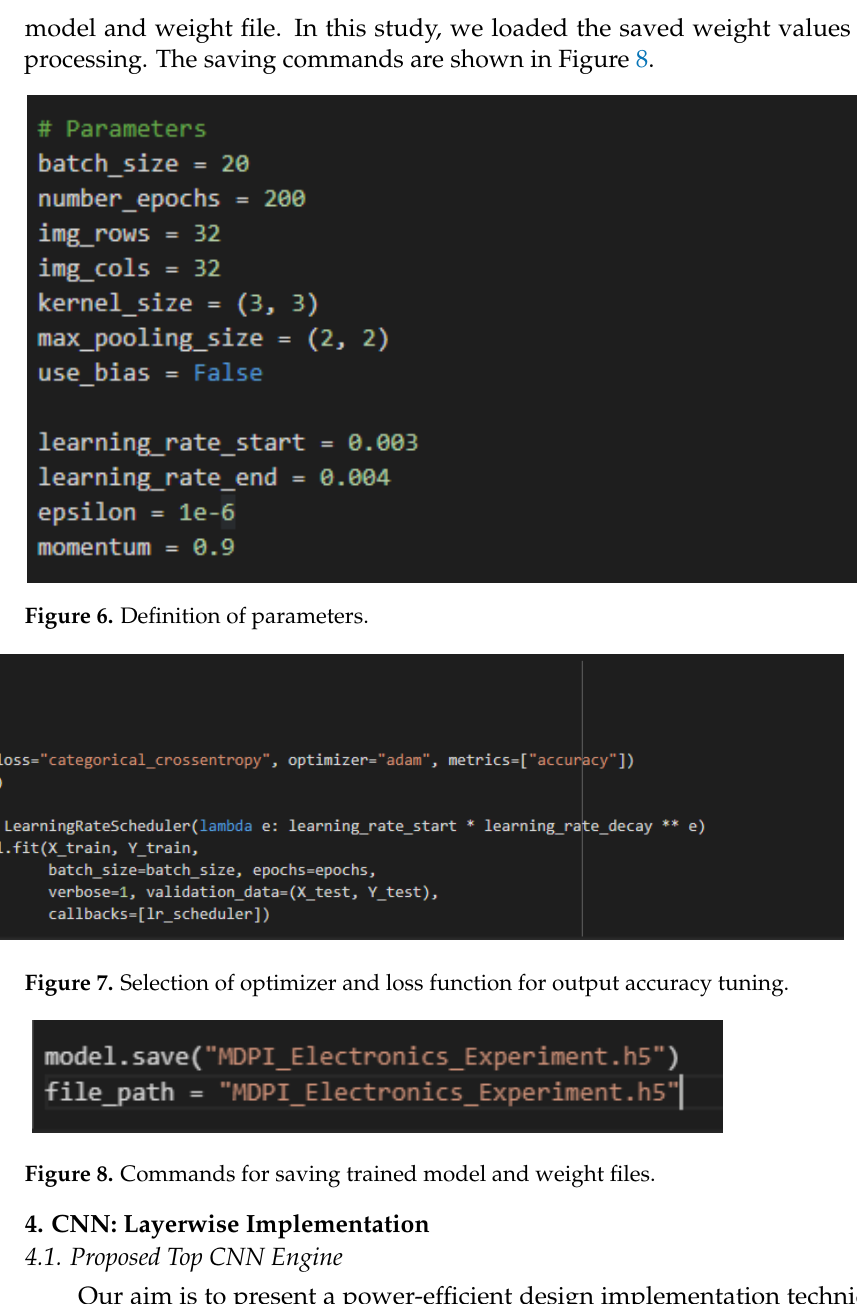
Figure 8. Commands for saving trained model and weight files.